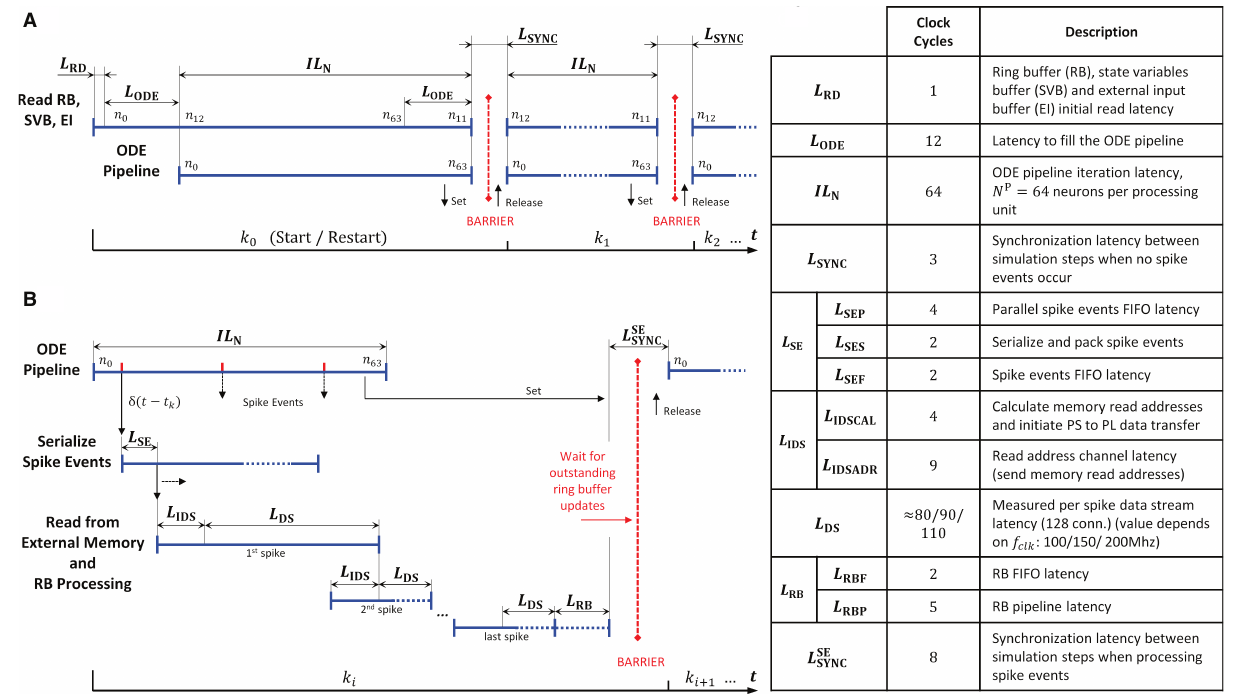
FIGURE 12 | Operating latencies. The scheduling of operations and the latencies associated with it, distinguishes two basic cases. (A) If no spike events occur, operation mainly reduces to ODE pipeline processing. (B) Normally, spike events have to be processed which changes and adds latencies. Postsynaptic spike events must be serialized, and for incoming presynaptic spike events the presynaptic data must be retrieved from external memory. (C) Table listing relevant latencies. The value of L DS cannot be derived from the microarchitecture; its average value was determined using an external logic